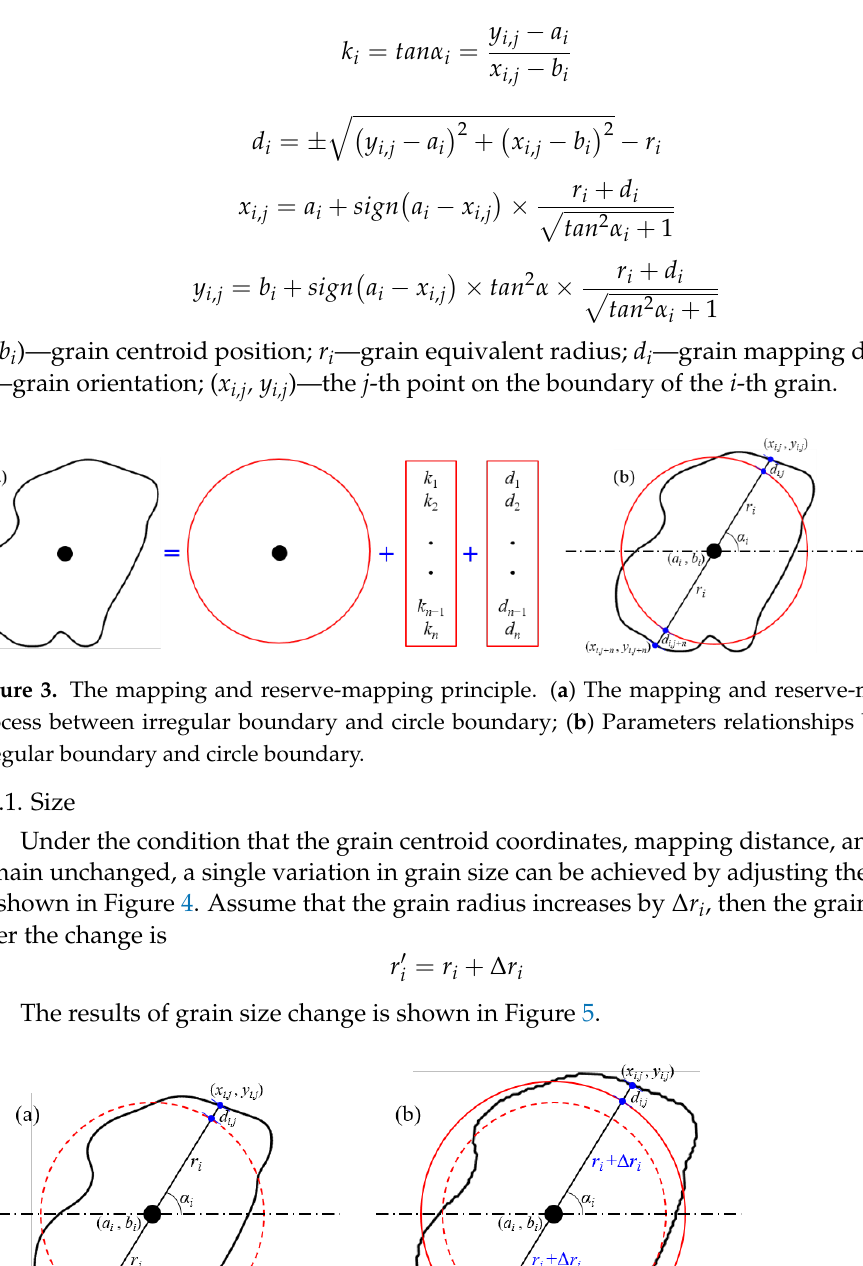
Figure 5. The results of grain size change. 2.2.2. Position Under the condition that grain radius, mapping distance, and slope remain un- changed, the only change of grain position and spacing can be realized by adjusting cen- troid position, as shown in Figure 6. Assume that Δ a i and Δ b i are added in the horizontal and vertical coordinates of the grain centroid, respectively, then the changed grain posi- tion is (𝑎 𝑖′ , 𝑏 𝑖′ ) = (𝑎 𝑖 + ∆𝑎 𝑖 , 𝑏 𝑖 + ∆𝑏 𝑖 ) (6) The results after the change of grain position is shown in Figure 7. Figure 6. The principle of grain position change. ( a ) Original relationship between grain boundary and mapping circle. ( b ) The relationship between them with the coordinates increasing Δ a i and Δ b i .